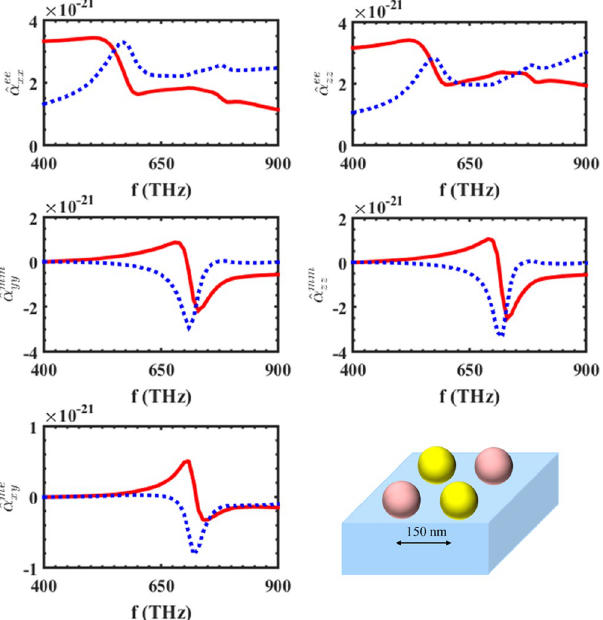
Figure 4. The major polarizabilities of the supercell shown in Fig. 3 placed on an infinite substrate, with ε r = 2.25 . The center-to-center distance of the elements is considered to be 150 nm.